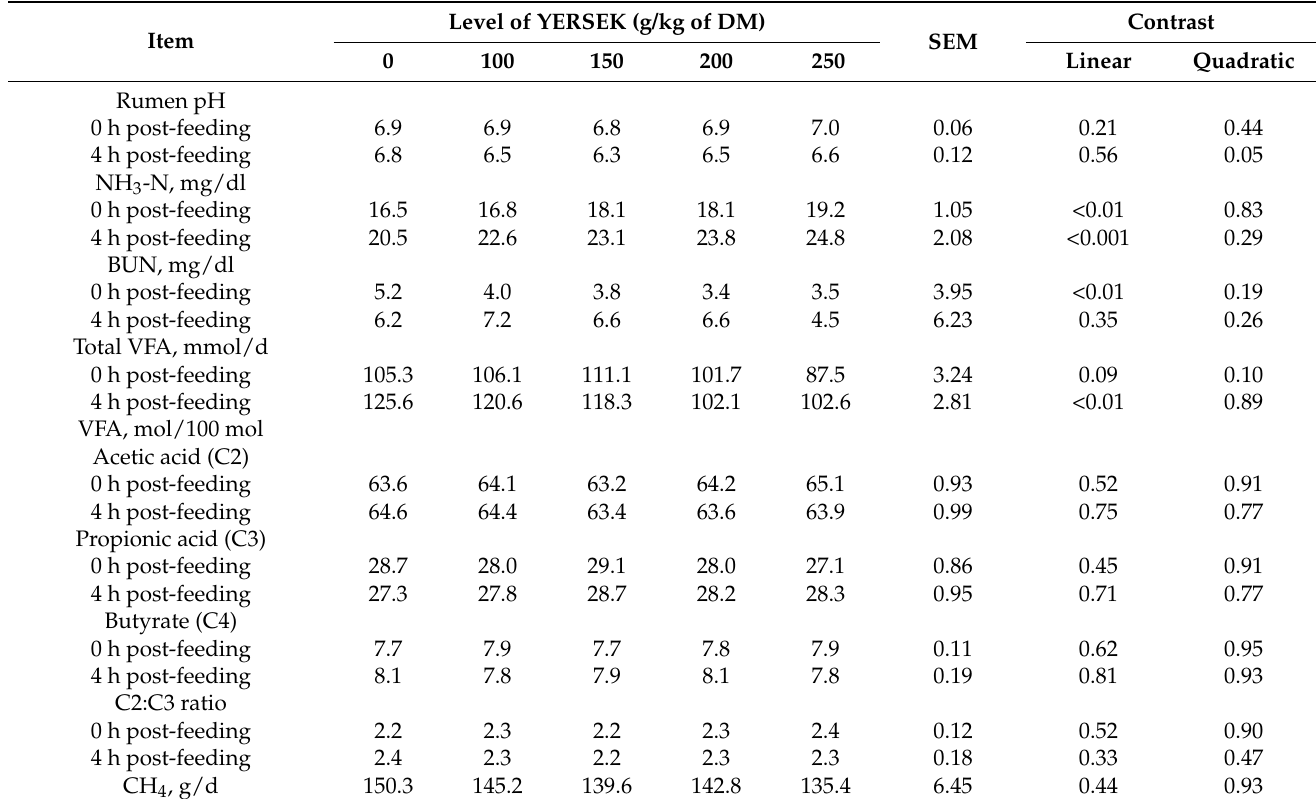
Table 4. Effect of YERSEK on ruminal fermentation and BUN in dairy heifers.